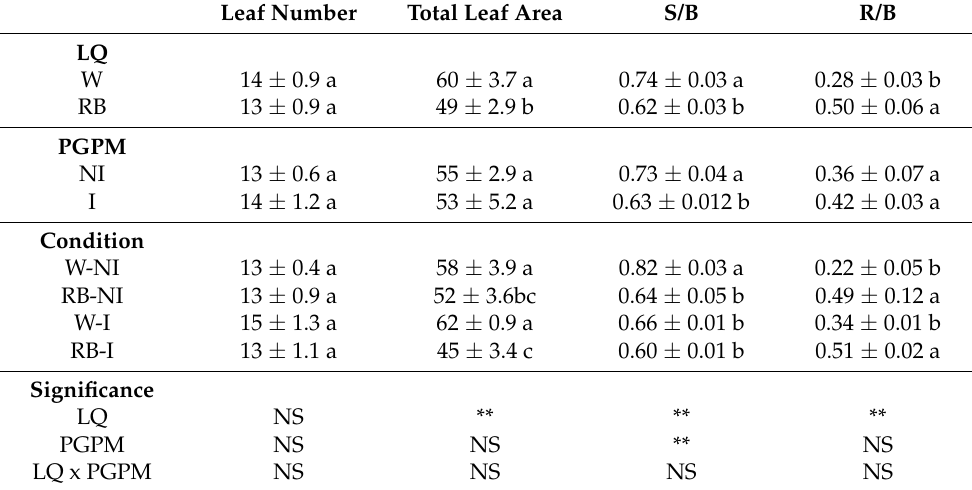
Table 1. Analysis of variance and comparison of means for leaf number, total leaf area, shoot/total biomass, root/total biomass of plants in response to light quality (LQ), plant-growth-promoting microbes (PGPM), and their interaction (LQ × PGPM). Different letters in each column indicate significant differences according to Student–Newman–Keuls (SNK) test ( p ≤ 0.05). NS—not significant; ** p ≤ 0.01.